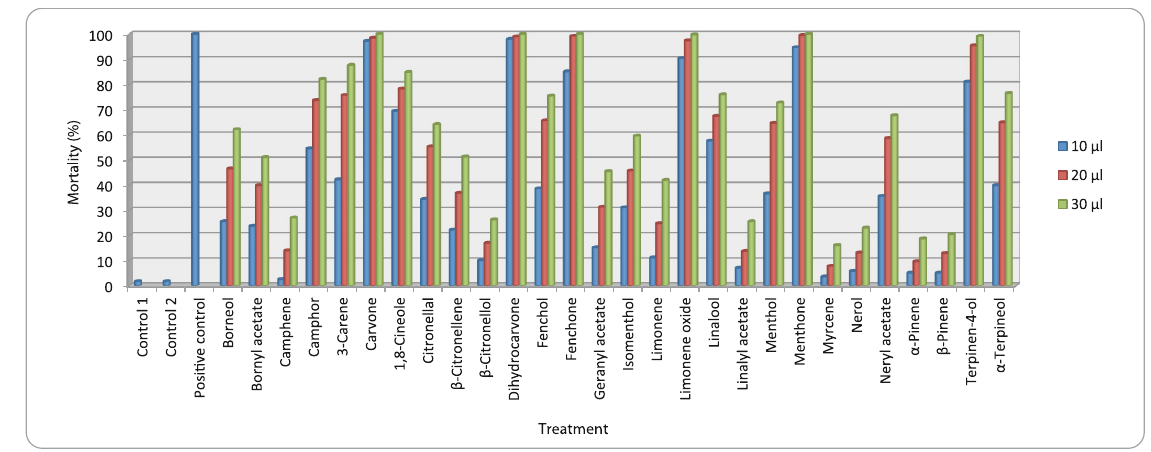
Fig. 1: Total mortality rates in adults of Sitophilus zeamais exposed to twenty eight monoterpenes at different